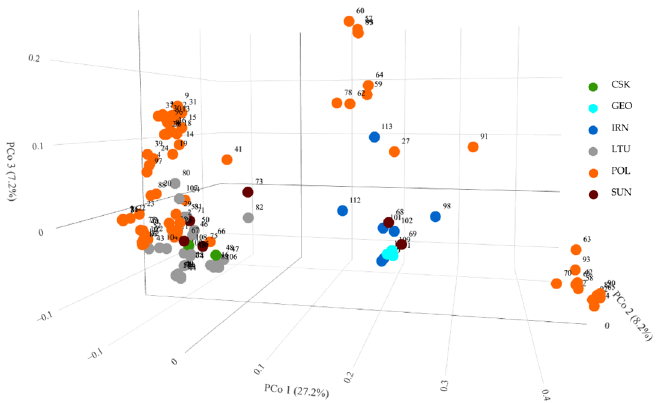
Figure 5. Results of Principal Coordinate Analysis (PCoA) for 116 spring barley landraces with an indication of the country of origin. The accession numbers according to Table S1. RotaTable 3D figures with an indication of the country of origin, grain type, and ear type can be found in the supplementary materials (Figures S3–S5).